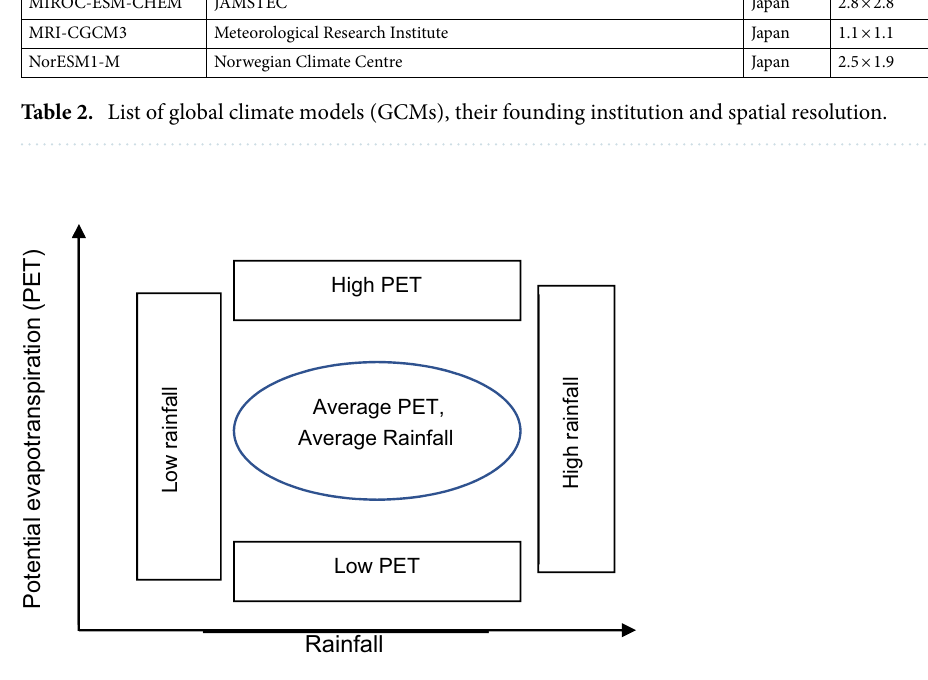
Figure 3. Schematic diagram of five climate scenarios by combining the low, average and high PET and